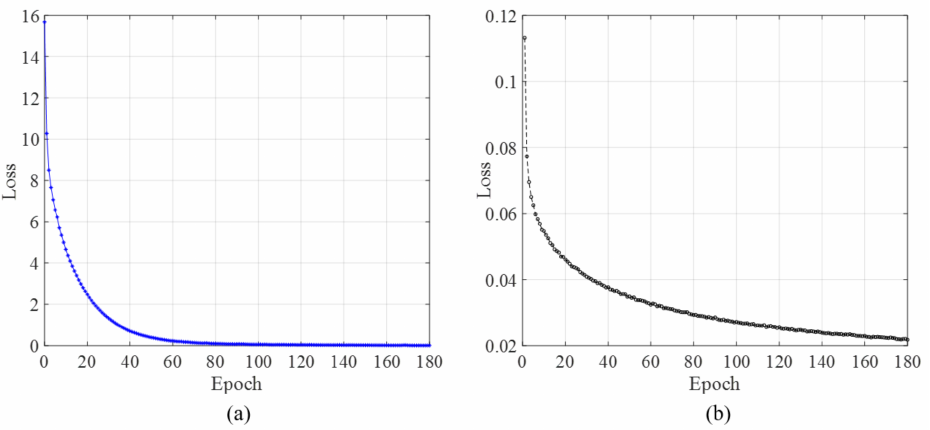
Figure 3. Loss curve of the semantic segmentation models in the training process: ( a ) U-net and ( b ) FCN.